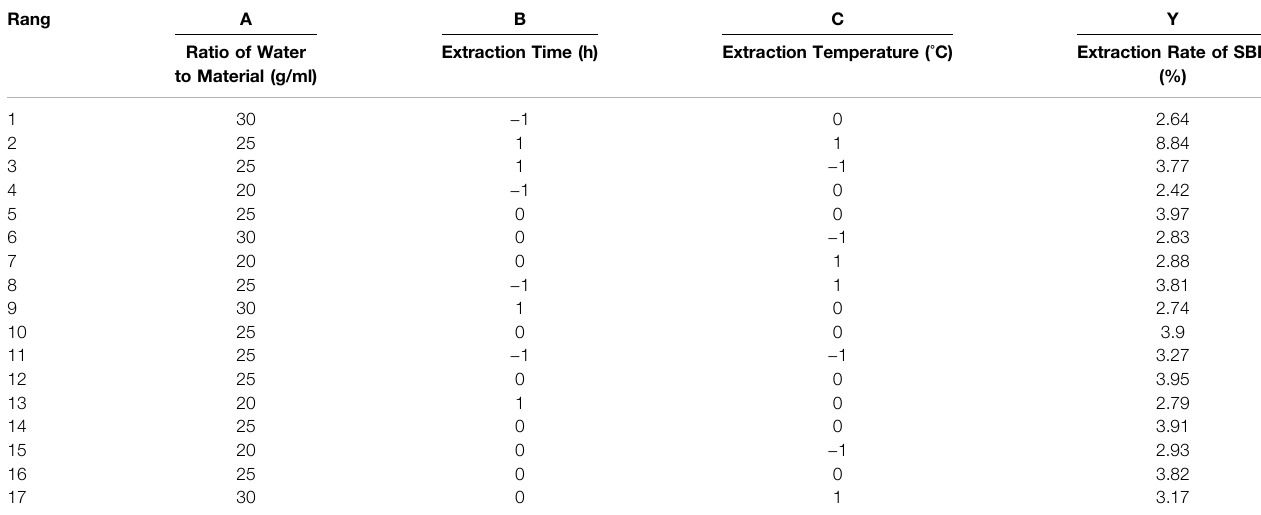
TABLE 1 | Response surface experimental design and results. Rang A B Ratio of Water to Material (g/ml)